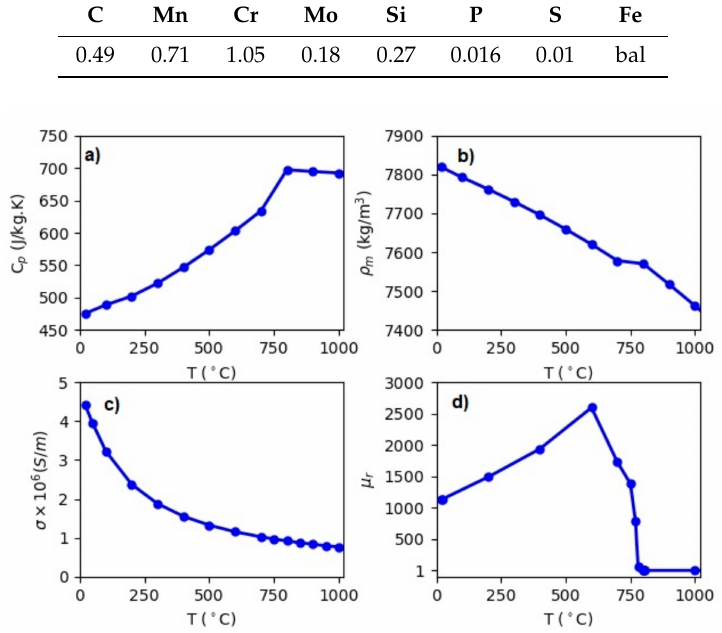
Table 1. The chemical composition of 50CrMo4 with values in the weight percent and Fe is balanced.